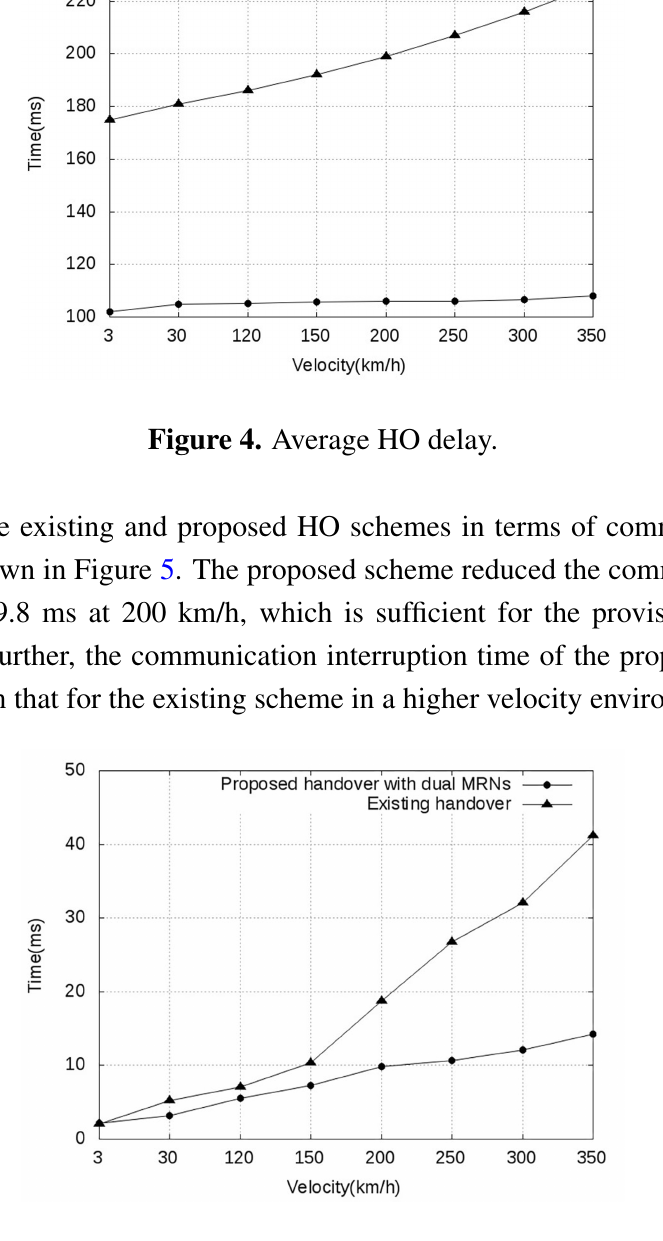
Figure 5. Communication interruption time during HO